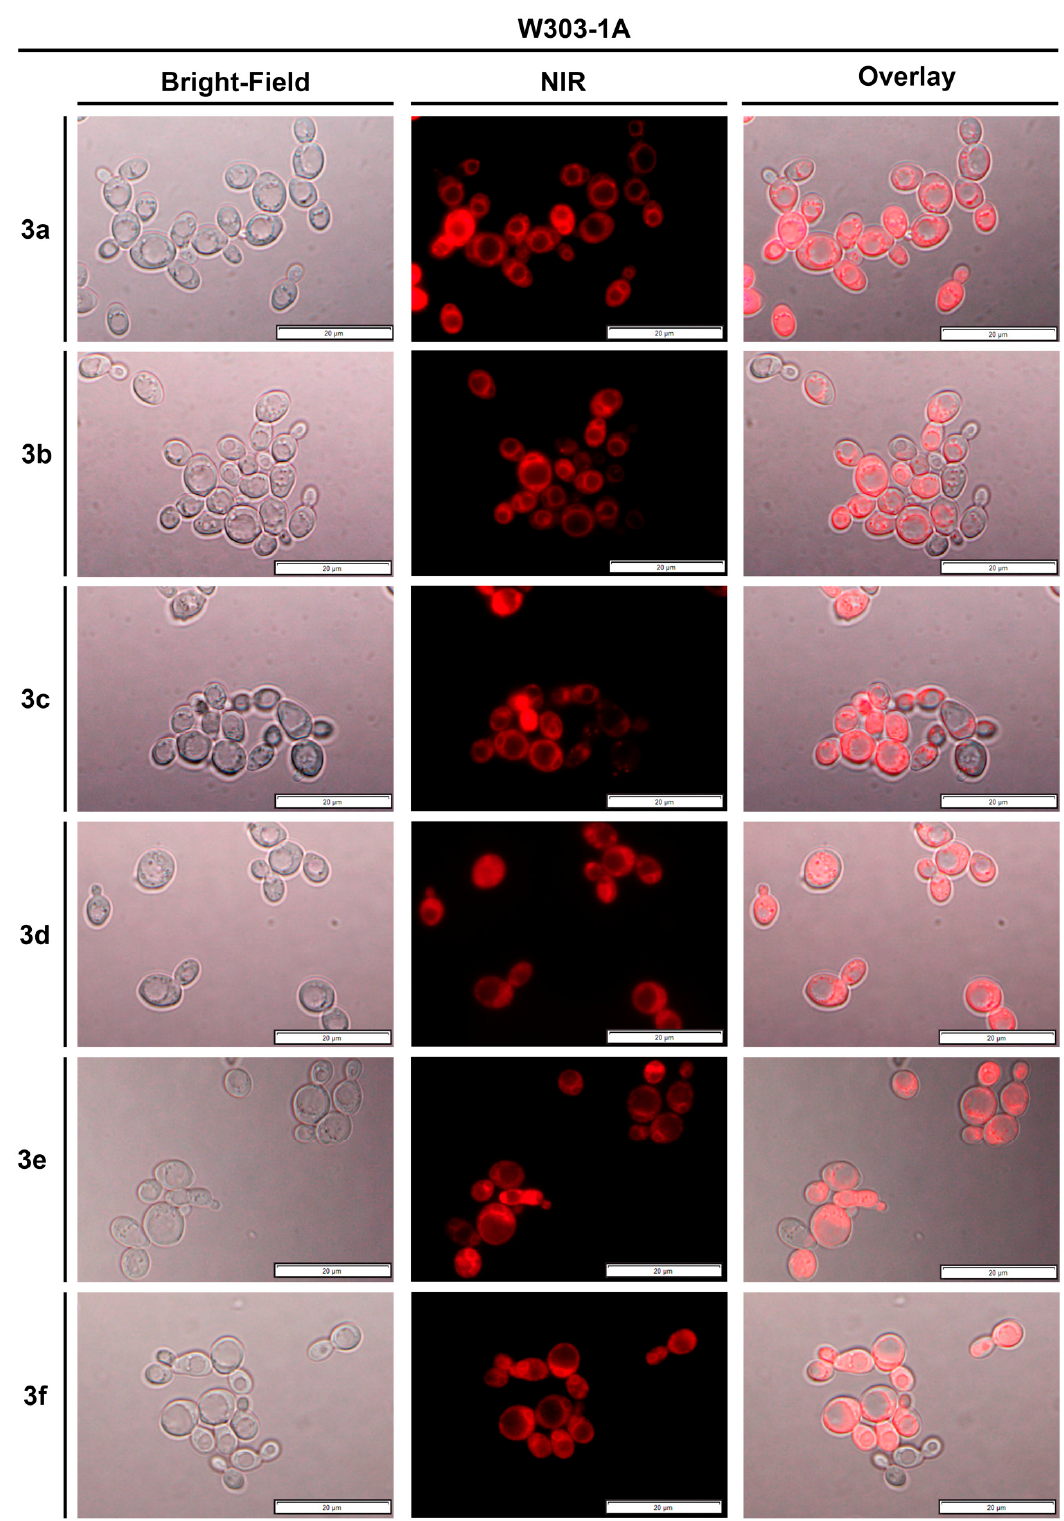
Figure 1. Intracellular distribution of benzo[ a ]phenoxazinium chlorides 3a–f. Fluorescence mi- croscopy images of W303-1A cells after incubation with 3a–f (MIC Concentrations) for 1 h. Samples were rinsed two times in PBS 1 × and mounted on a slide for observation with a 60 × oil immersion objective, using the adequate filters U-FDICT, ET-CY5-FAR-RED (exciter filter: 595–645 nm/emission filter: 665–715 nm). Representative images of three independent experiments. Scale bar 20 µ